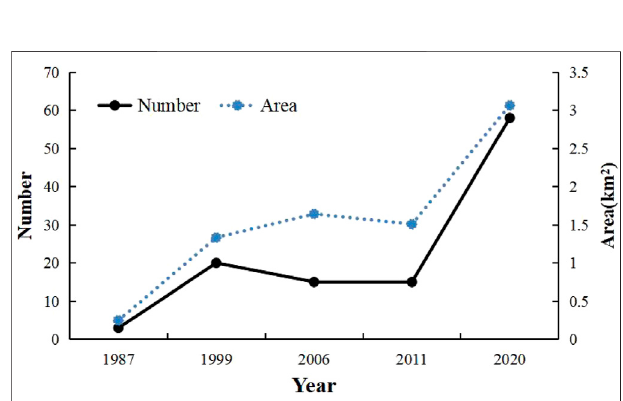
FIGURE 9 | Variations of the counts and areas of glacial lakes in the Turgen Daban